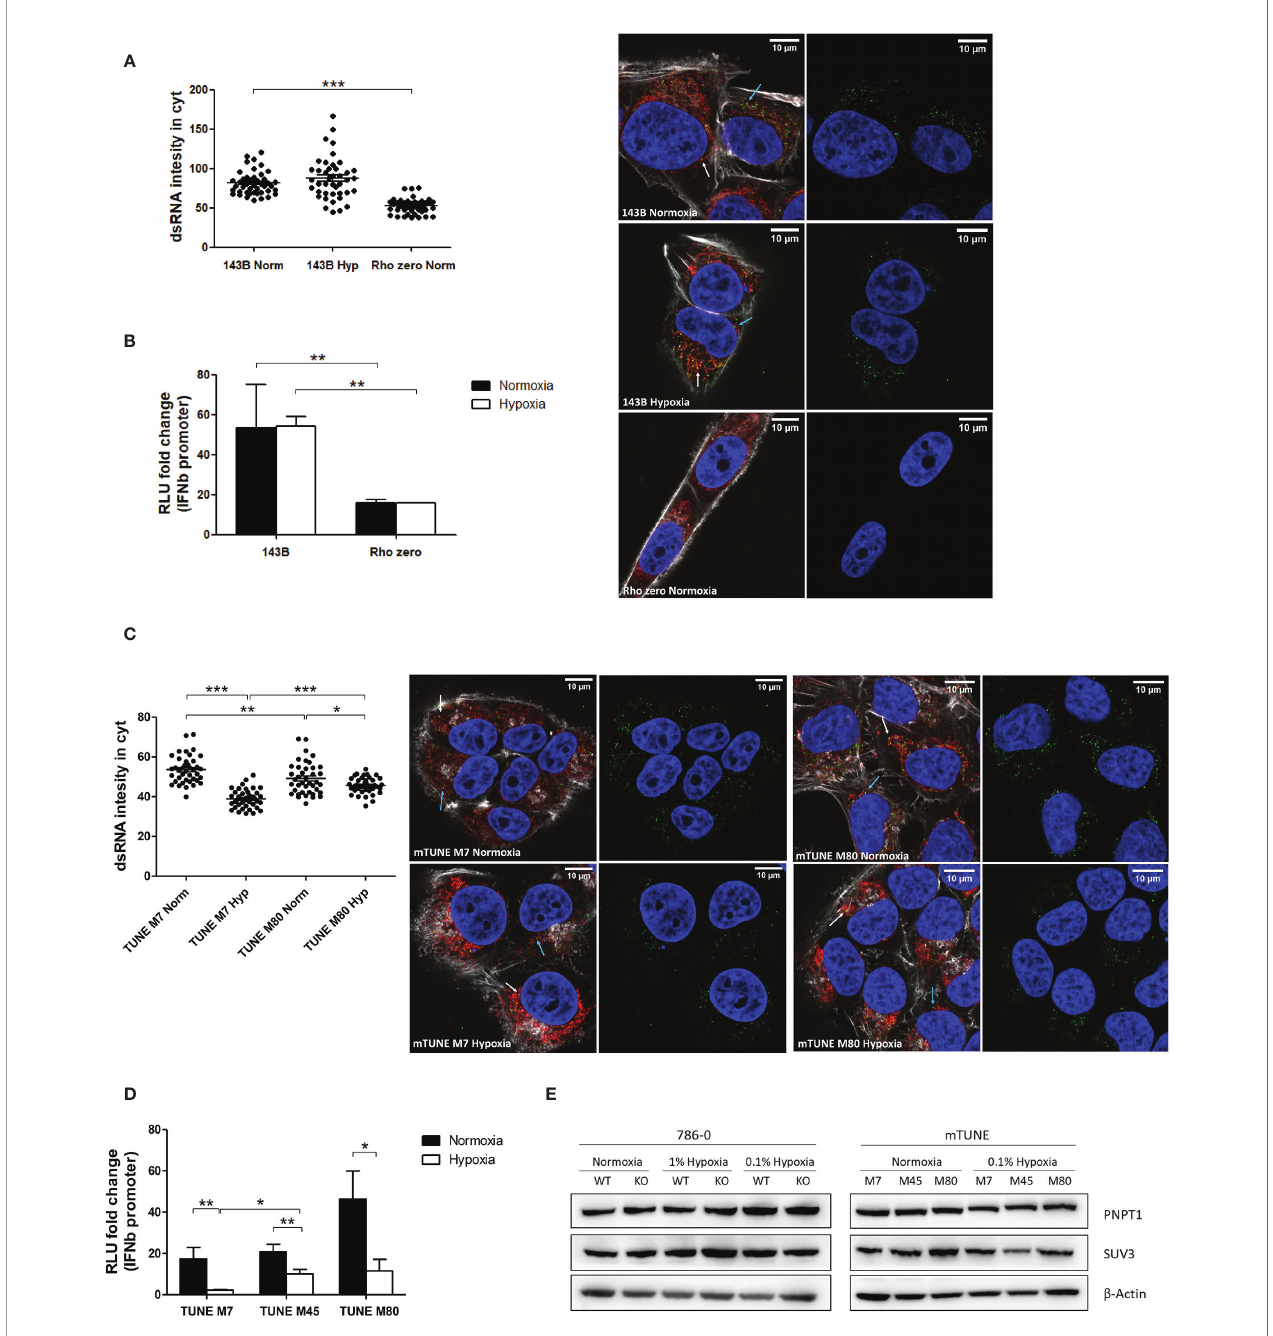
FIGURE 3 | Mitochondrial alterations did not affect dsRNA staining reduction under hypoxia. (A) Representative images showing dsRNA staining using J2 antibody in 143B WT cells in normoxia (n=44 cells) or 0.1% hypoxia (n=42 cells) for 48h and in 143B lacking mtDNA (Rho Zero) exposed to normoxia (n=40 cells) from 3 independent replicates. (B) IFN b promoter stimulation was evaluated using RNA from 143B WT and Rho Zero cells cultured in normoxia and 0.1% hypoxia for 48h (n=3; RLU, relative light units). (C) Representative images showing dsRNA staining in U2OS isogenic lines harbouring 7% vs 80% of heteroplasmy for the mtDNA mutation m8993T>G (mTUNE M7 normoxia n=40 cells and 0.1% hypoxia n=40 cells, M80 normoxia n=40 cells and 0.1% hypoxia n=40 cells) from 3 independent replicates. (D) IFN b promoter stimulation using RNA from mTUNE M7, M45 and M80 cells in normoxia and 0.1% hypoxia for 48h (n=3). (E) Western blot showing PNPT1 and SUV3 dsRNA degrading enzymes protein levels in normoxia and hypoxia (n=3). Number of replicates indicate biological replicates and data is shown as mean ± SEM. *p < 0.05, **p < 0.01, ***p < 0.001. Green: J2 antibody staining, blue: DAPI, and red: MitoTracker staining. White arrow: dsRNA inside of mitochondria, blue arrow: dsRNA outside of mitochondria. Scale bars correspond to 10 m m.